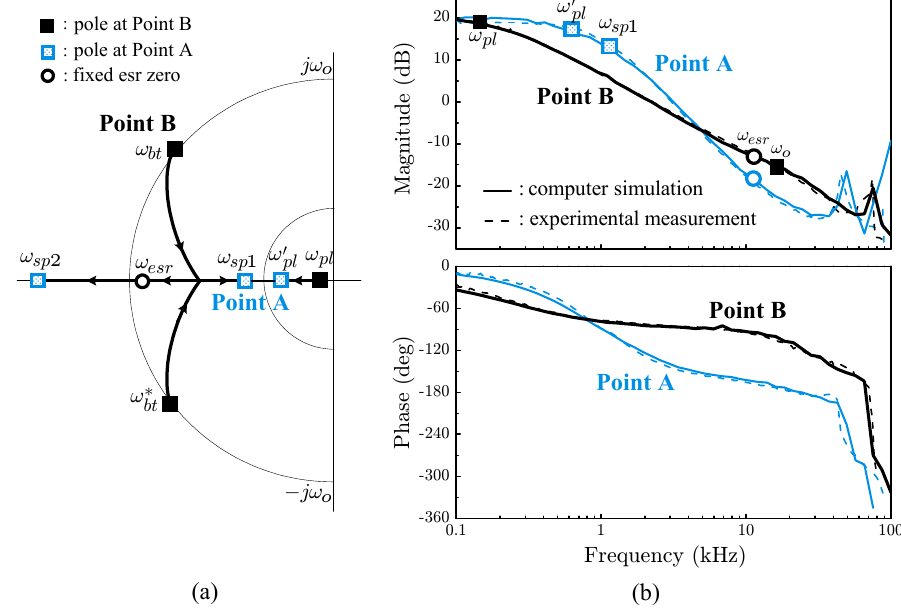
Figure 4. Power stage dynamics of experimental LLC converter. ( a ) Pole/zero trajectory of frequency-to-output transfer function; ( b ) Experimental Bode plot of control-to-output | = | ω | = | ω ∗ transfer function G : ω vco o bt bt